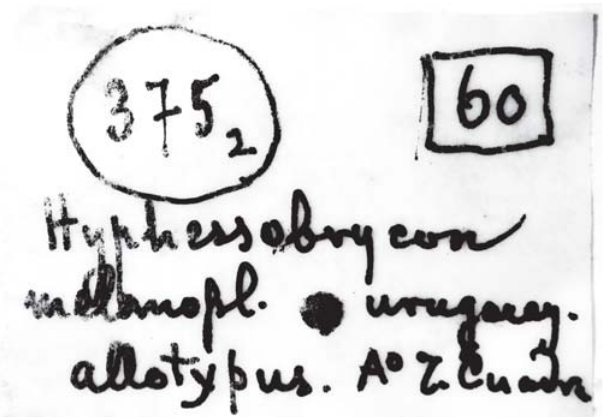
Fig. 2. Original label found in the jar of the syntype